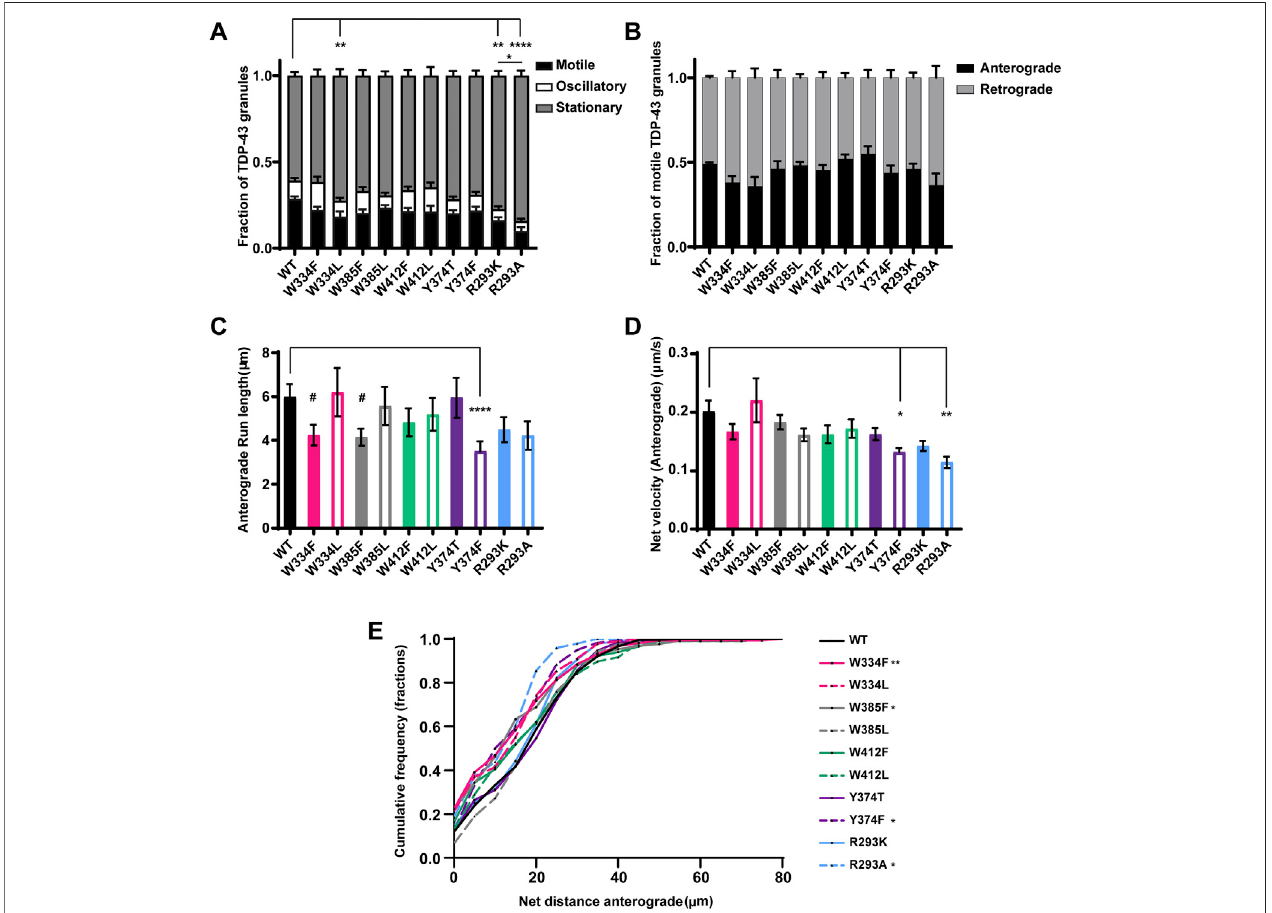
FIGURE5| TDP-43mutationsdisruptingRGGmotifofLCDandWresidueof α -helicaldomaindisplaydefectsinanterogradetransport. (A) WTTDP-43orTDP-43 LCD W/Y/R mutant kymographs from 3 independent experiments are analyzed to determine the motility of different RNP granules. Fraction of motile, oscillatory and stationary RNP granules are plotted. (B) The fraction of motile RNP granules for WT TDP-43 and each of the TDP-43 LCD W/Y/R mutant (shown as black bars in Figure 5A ), are further categorized as granules travelling in retrograde or anterograde direction and the resulting fraction is plotted. (C) The run lengths ( μ m) of motile WT TDP-43 or TDP-43 LCD W/Y/R mutant RNP granules moving in anterograde direction are determined using custom semi-automated analysis in MATLAB softwareandtheresultingrunlengthsareplotted(N=3,WT n =75,W334F n =72,W385F n =87andY374F n =80from13to15neuronsfromeachcondition). (D) The anterogradenetvelocity( μ m/s)foreachofthemotileWTTDP-43orTDP-43LCDW/Y/RmutantRNPgranulewasdeterminedusingcustomsemi-automatedanalysisin MATLAB and the average net velocity is plotted (N = 3, WT n = 88, Y374F n = 105 and R293A n = 40). Error bars represent standard error mean. (E) Cumulative frequency distribution of TDP-43 WT and LCD W/Y/R mutant RNP anterograde net distances, N = 3 independent experiments. One way ANOVA (Kruskal – Wallis test withDunn ’ scorrectionformultiplecomparisons)isusedtodeterminethestatisticallysigni fi cantdifferenceamongdifferentsamples.# p < 0.1,* p < 0.05,** p < 0.01,*** p < 0.0005 and **** p <